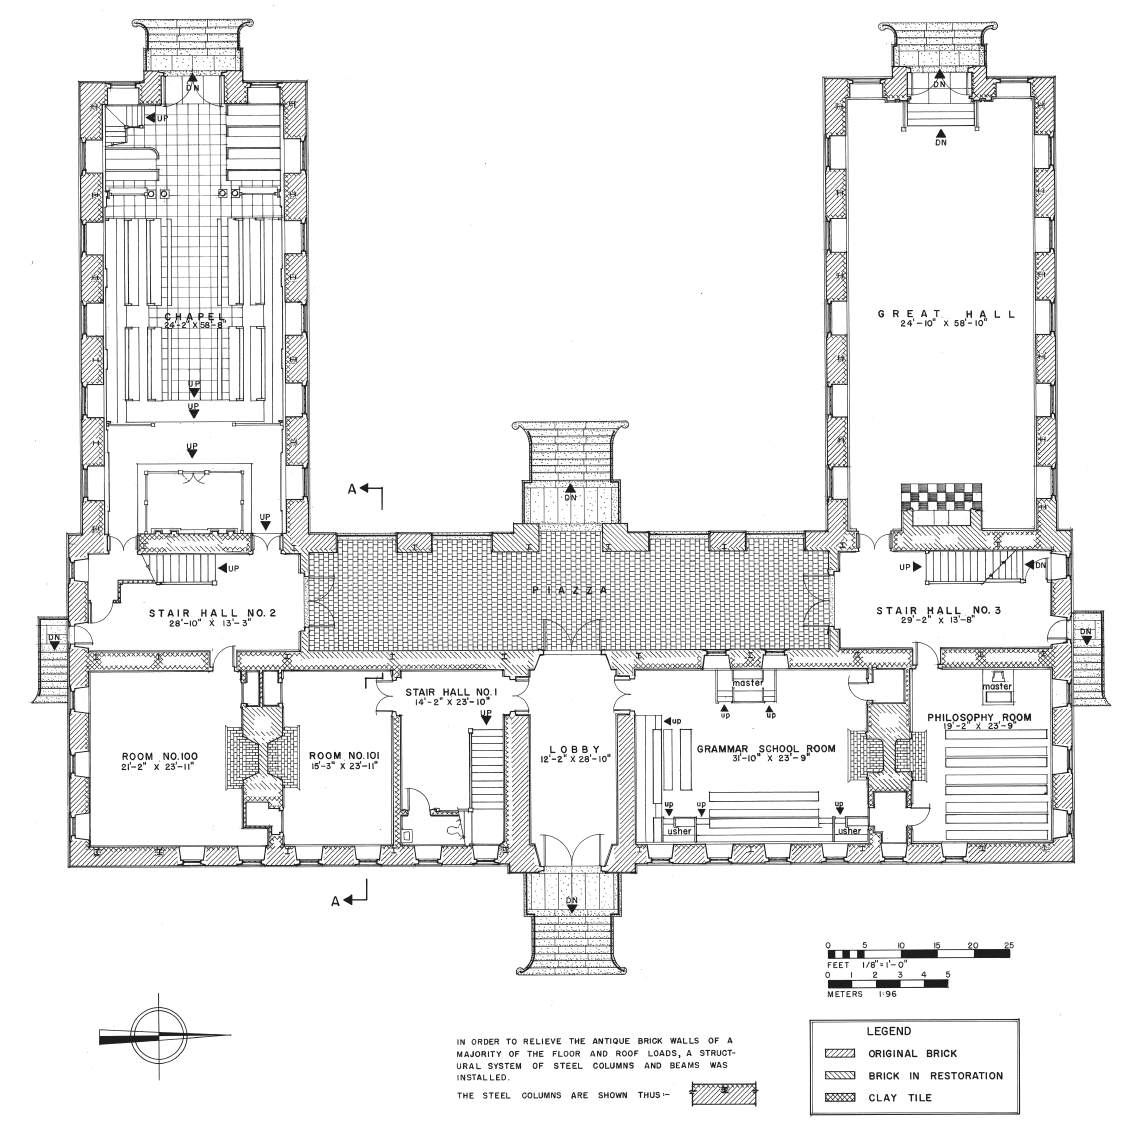
Figure 3 Wren Building, First Floor Plan, College of William and Mary, Williamsburg, Virginia (Source: Historic American Buildings Survey, U.S. Library of Congress, Washington,